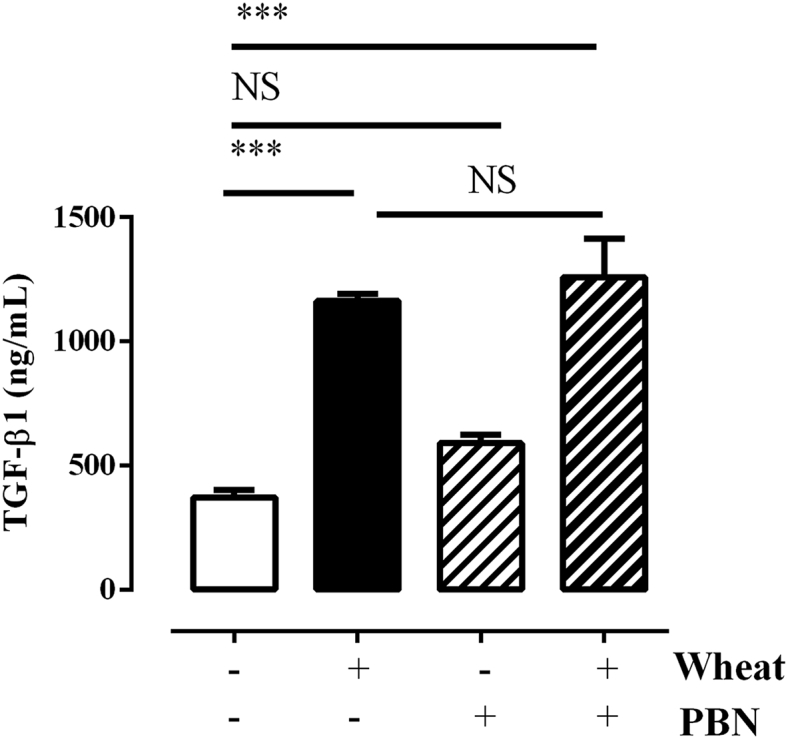
Wheat-induced release of TGF-β1 from HAECs co-cultured with peripheral blood neutrophils (PBNs) of asthmatic patients. A549 cells (1 × 105) were seeded onto the lower chamber of Transwell system, stimulated with wheat flour extract (10 μg/mL). PBNs (5 × 105 cells) were suspended onto the upper chamber of Transwell system and co-incubated with A549 cells for 48 h. P values were analyzed by one way ANOVA with Tukey post hoc test. ***P < 0.001 compared between the indicated groups; NS, not significant. TGF-β1, transforming-growth factor β1